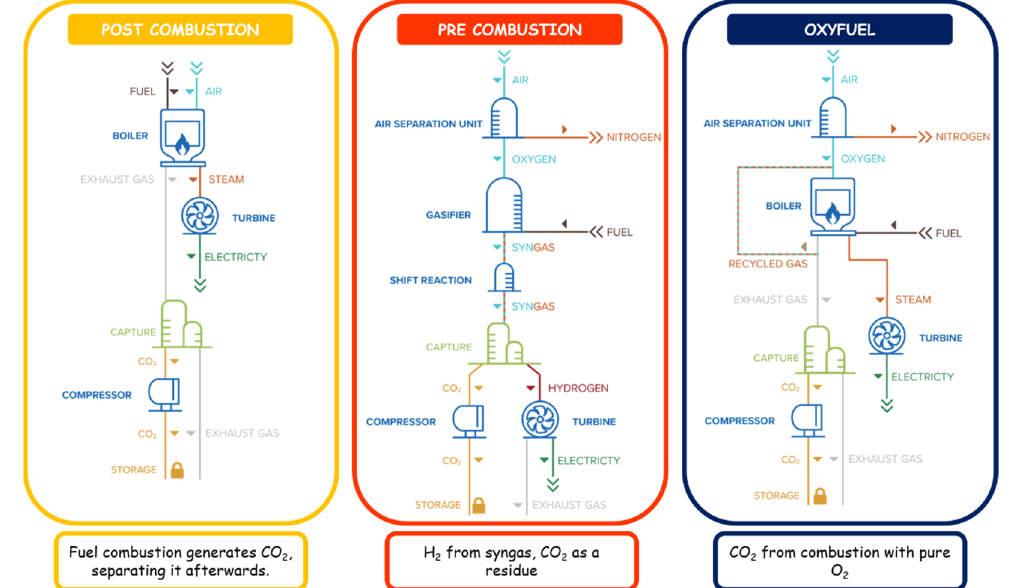
Figure 10. Techniques for capture of carbon dioxide during power generation (provided by Global carbon capture and storage (CCS) Institute). Source: [120,126].